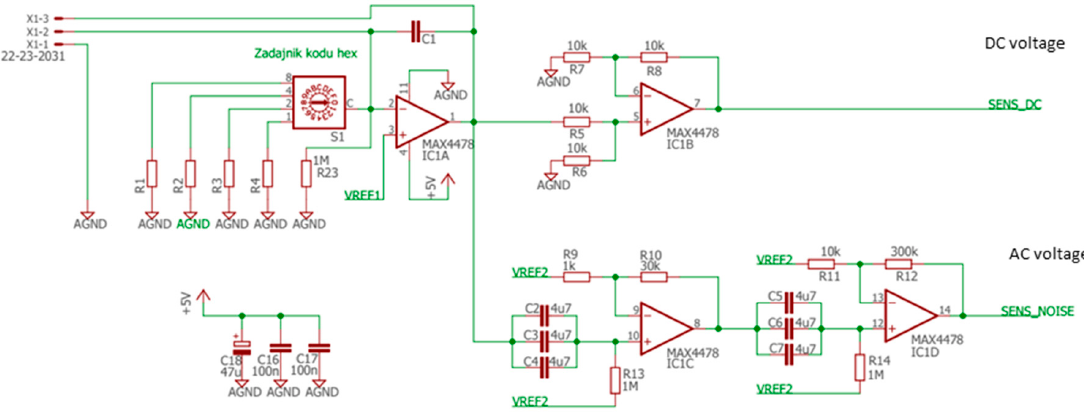
Figure 2. Electronic circuit.